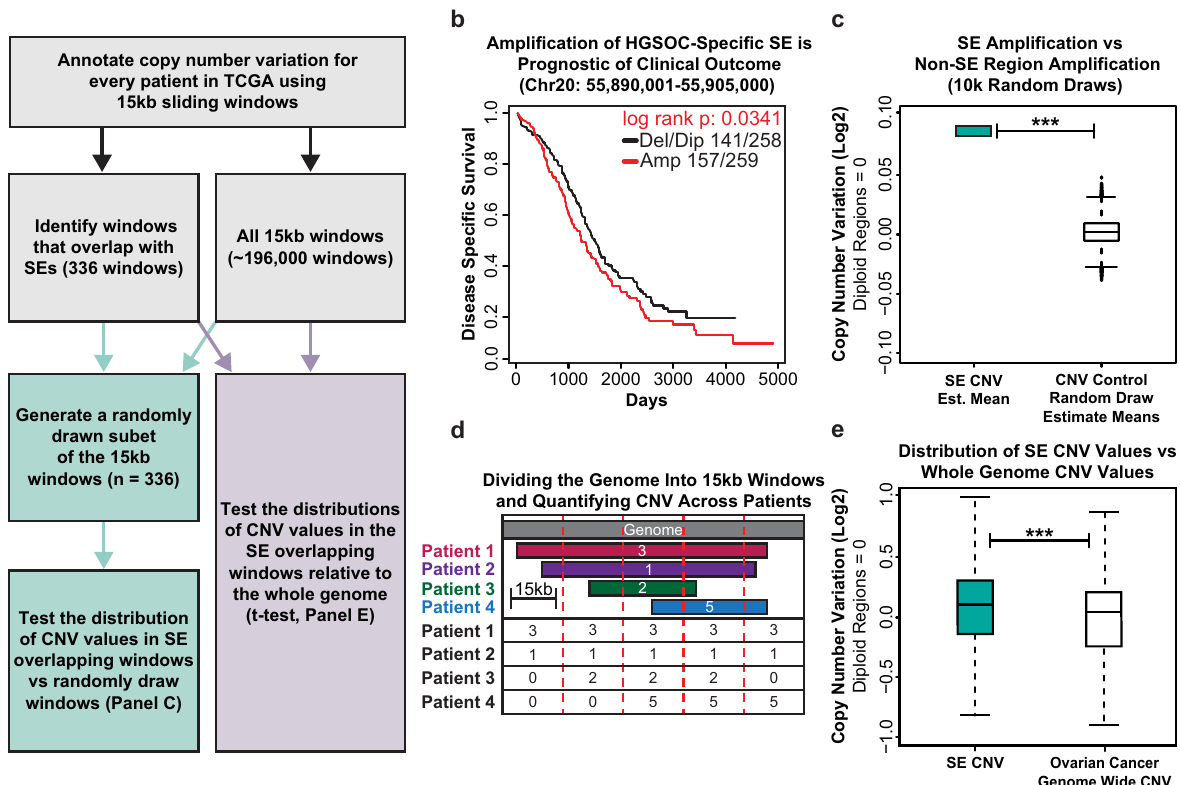
Fig. 2 BRD4 bound super-enhancers are enriched for copy number alterations in ovarian cancer patients. a Flowchart of the analysis strategy used to quantify the relationship between SEs de fi ned in OVCAR3 cells and copy number alterations in high-grade serous ovarian cancer patients. b Copy number Kaplan – Meier plot for a 15 kb window that overlaps an OVCAR3 de fi ned SE at Chr20:55,890,001 – 55,905,000. The red line represents HGSOC patients with copy number ampli fi cation of this region above the median, the black line represents patients with copy number below the median. c Summary plot showing the results of 10,000 comparisons between the copy number ampli fi cations at SE overlapping windows versus 10,000 randomly drawn subsets of the genomic background. Asterisks represent signi fi cant differences as determined by a one-sided t -test and validated with a Mann – Whitney- U non- parametric comparison. n = 1 (left), n = 10,000 (right) with all samples being independent. d Cartoon showing the computational approach used to